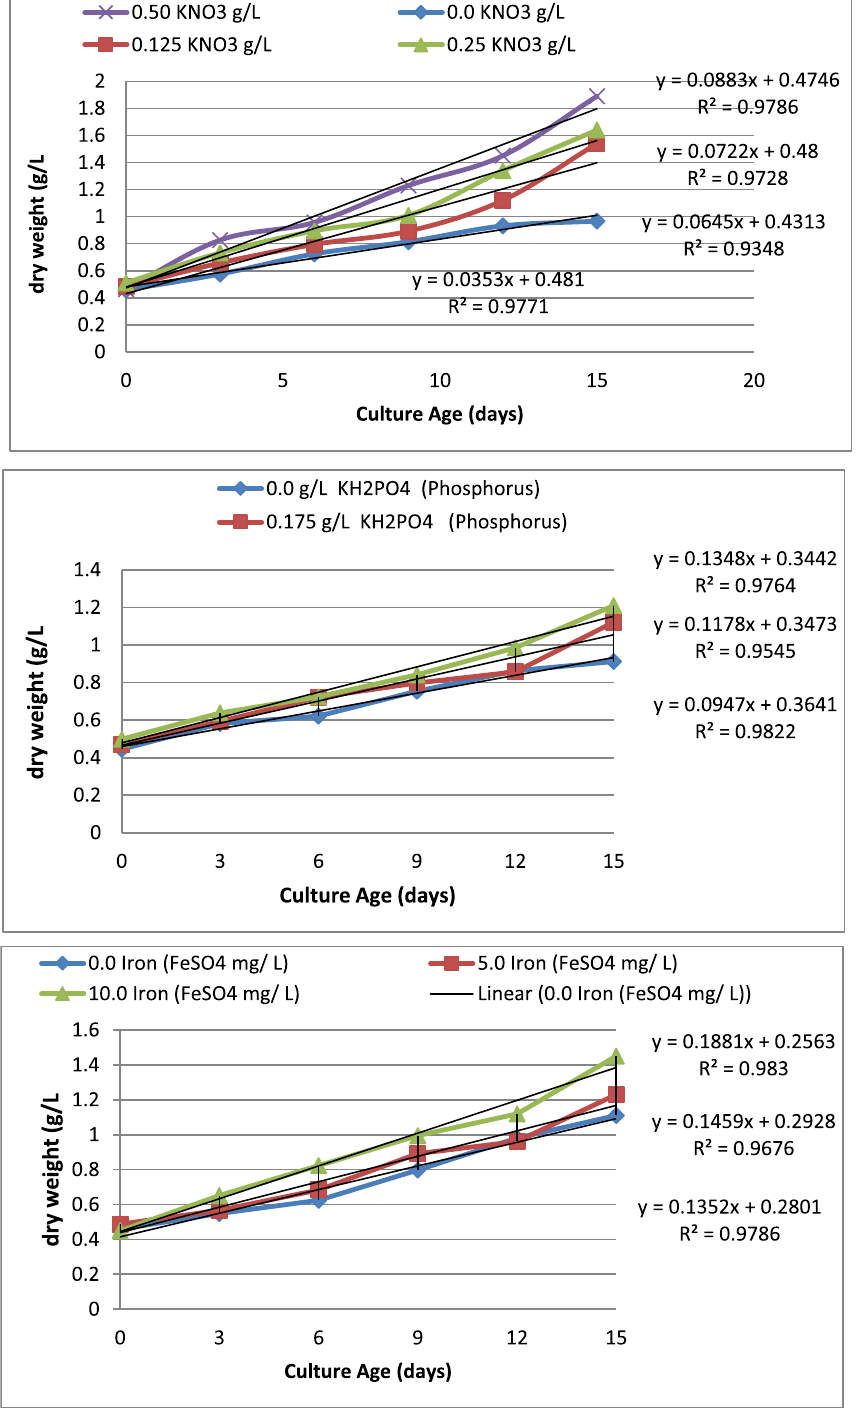
Fig. 2 Impact of elements concentrations on Pseudochlorella pringsheimii Biomass ( dry weight